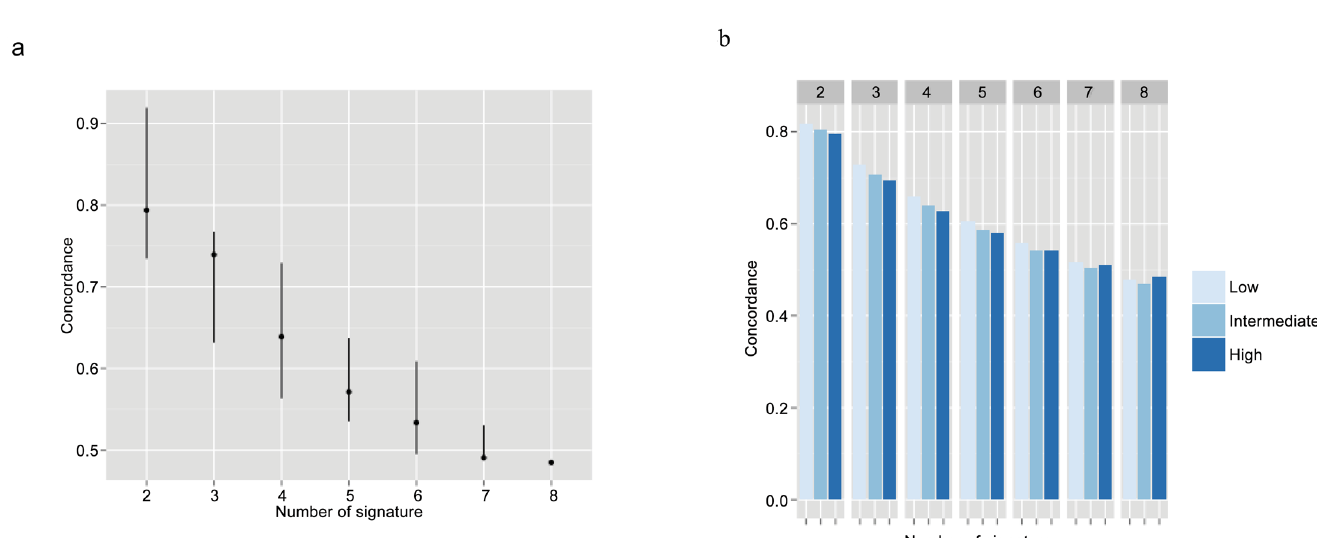
PLOS ONE | DOI:10.1371/journal.pone.0148957 February 19,